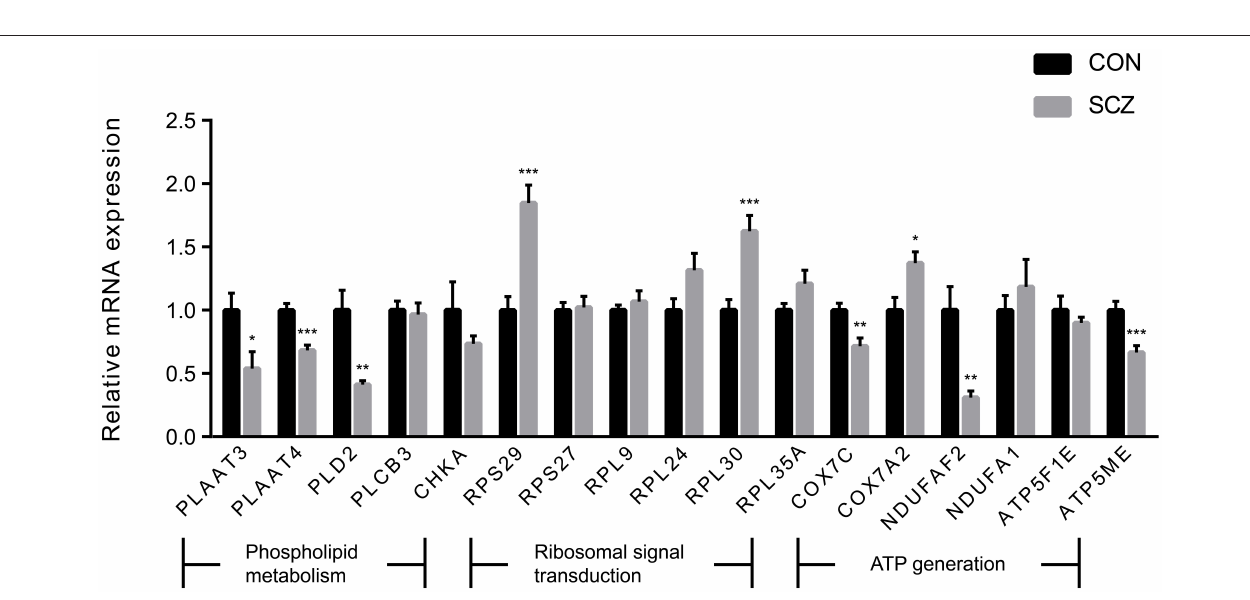
FIGURE 4 | The results of IPA pathway analysis in (A) DLFC-blue, (B) AnCg-pink, (C) DLPFC-brown, and (D) nAcc-turquoise clusters. The y-axis represents all pathways enriched by the DEG cluster, and the x-axis represents the p -value after Benjamini–Hochberg correction.